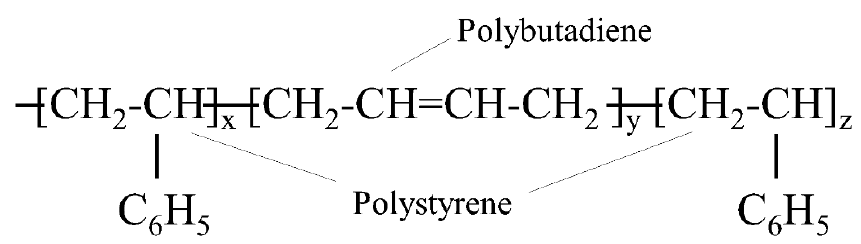
Figure 6. Structure of SBS modifier.